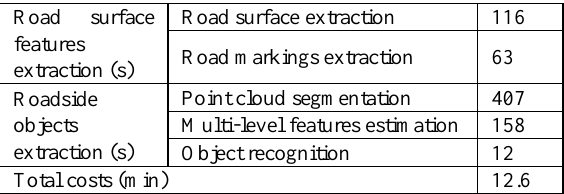
Table 2. Time performance of the proposed method.